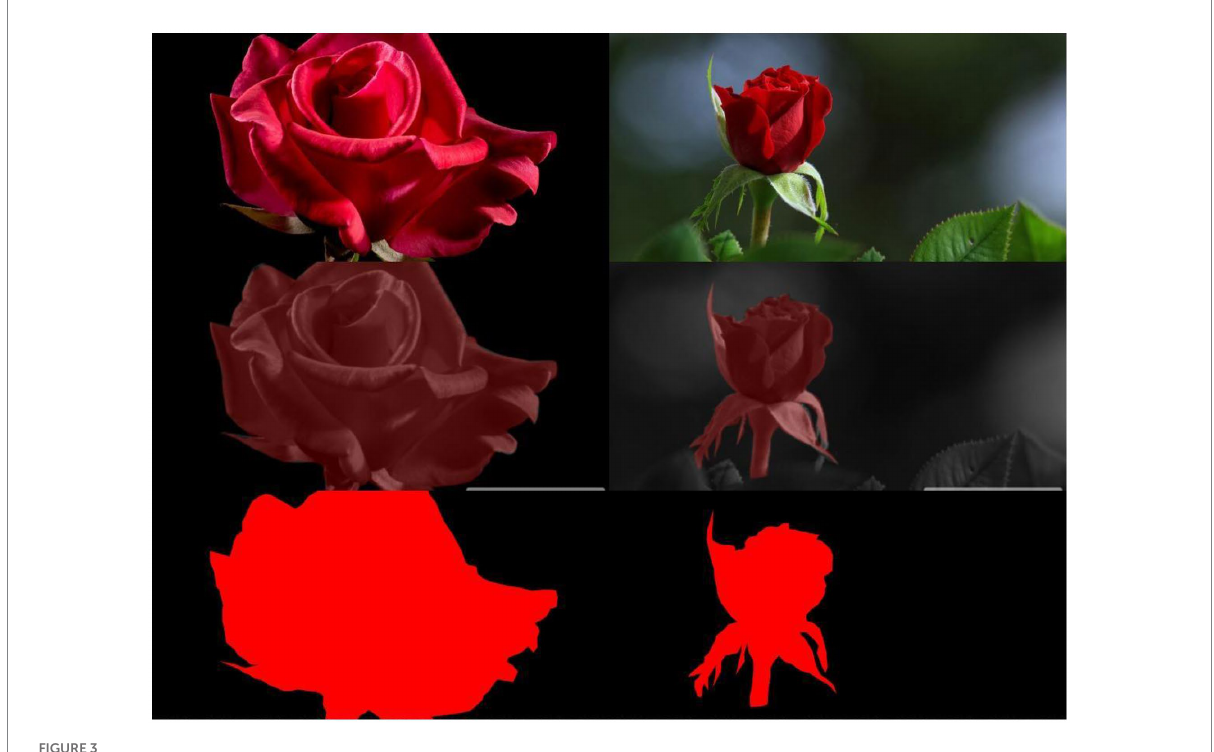
FIGURE 3 Examples of visually distant and proximate